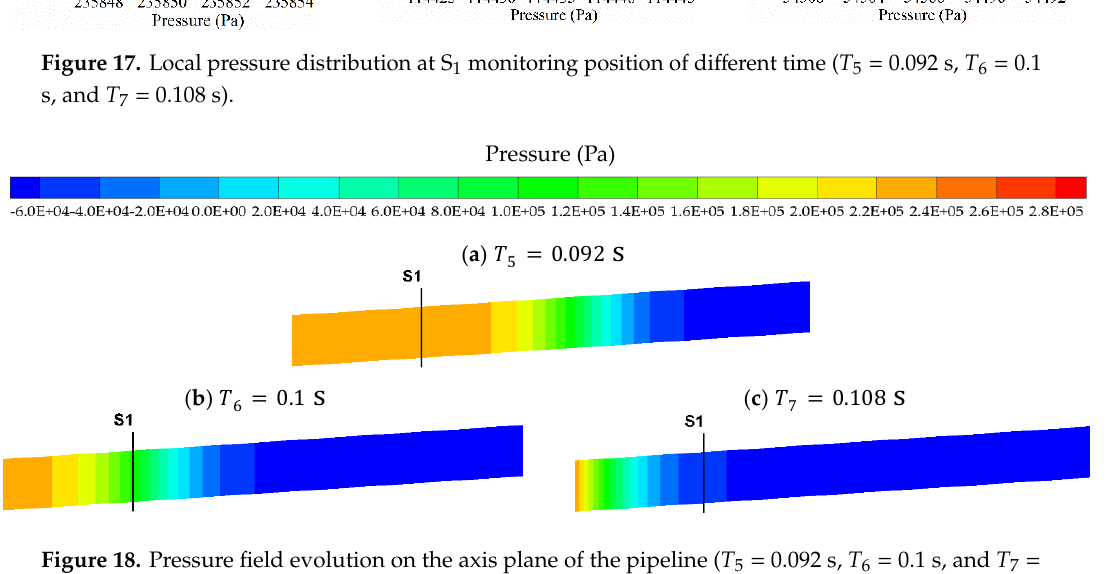
Figure 19. Axial velocity distribution at different time ( 𝑇 8 = 0.116 s and 𝑇 9 = 0.124 s ) of S1 monitoring point.